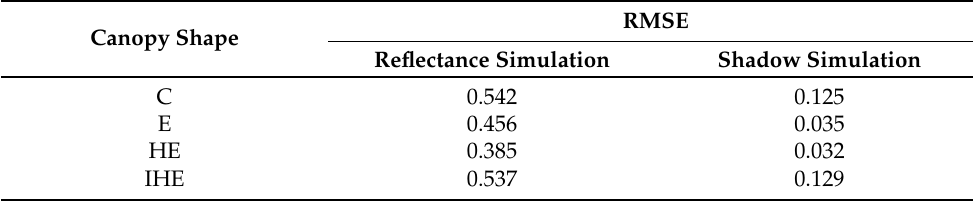
Table 6. RMSE of Sentinel-2 Band 4 reflectance simulation and shadow simulation in each canopy shape (C: cylinder, E: ellipsoid, HE: half ellipsoid and IHE: inverted half